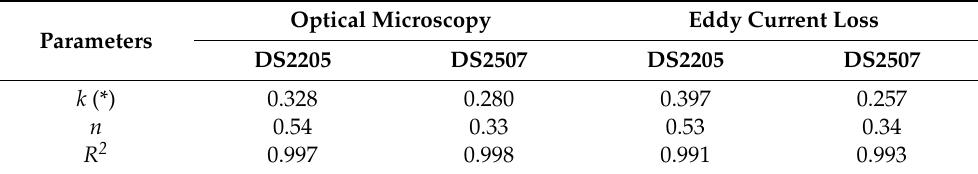
Table 2. Experimental parameters of Equation (1) after fitting the oxide thickness as a function of exposure time with each method for measuring of oxide thickness in the alloys. (*) Units of k expressed in µ m · h − 1/2 for DS2205 and µ m · h − 1/3 for DS2507. Optical Microscopy Eddy Current Loss Parameters DS2205 DS2507